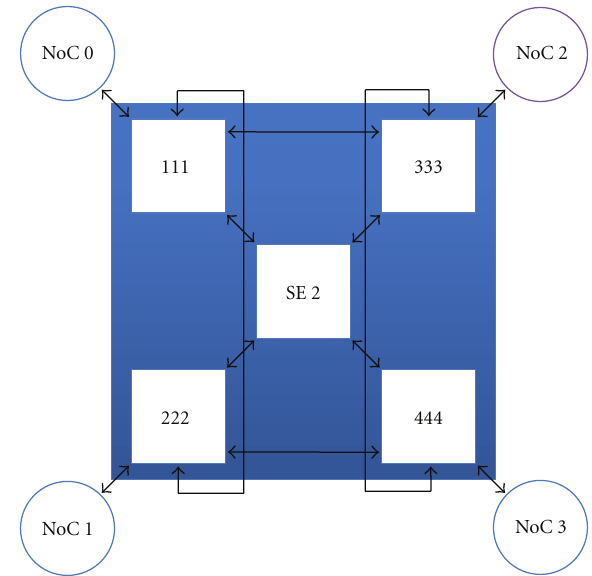
Figure 8: The simulation state of NiP-PNN model at first step of best case.